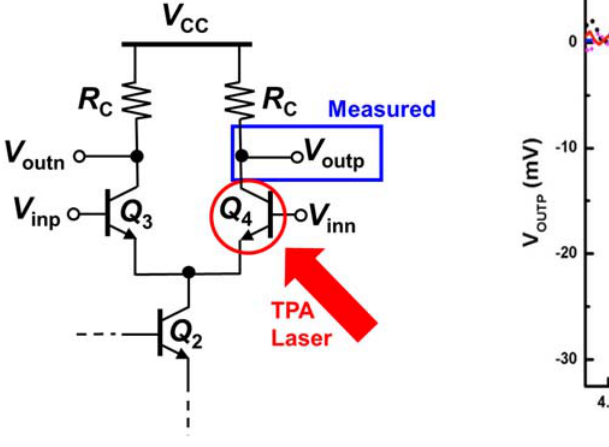
Figure 4. ( a ) The output transistor Q 2 of the DC current mirrors of all four CML circuits in Figure 2 was struck by the two-photon-absorption (TPA) laser; ( b ) Transient responses at the positive output terminal (Q 4 collector) of the differential pair was measured.